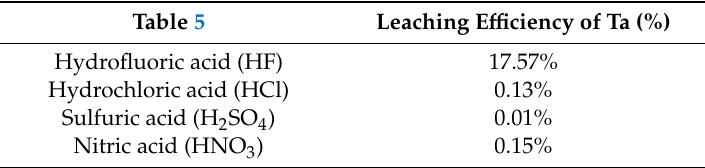
Table 5. Leaching e ffi ciency with respect to tantalum of the di ff erent inorganic acids. Table 5. Leaching efficiency with respect to tantalum of the different inorganic acids. Table 5. Leaching efficiency with respect to tantalum of the different inorganic acids. Table 5 Table 5 Table 5